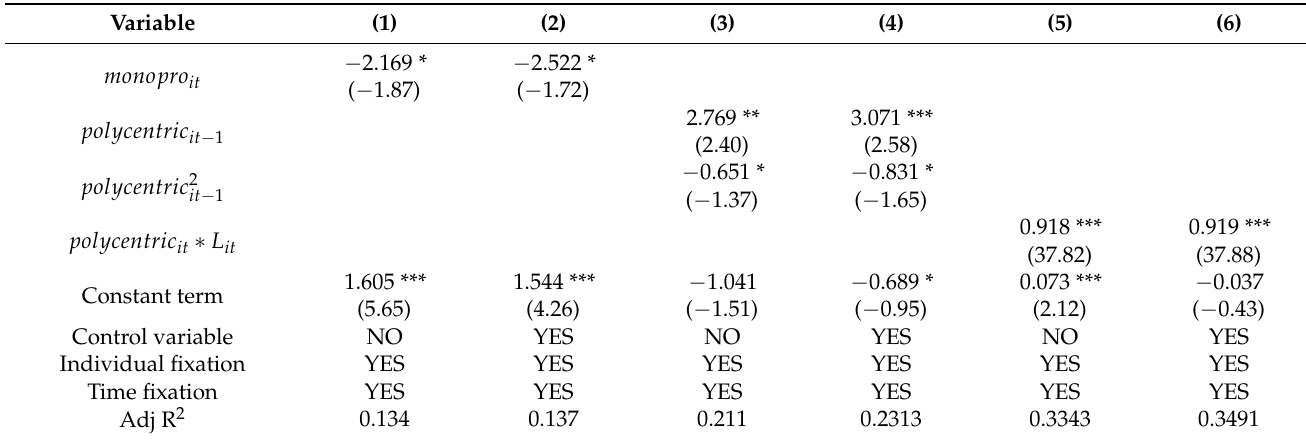
Table 5. Regression result analysis of robustness